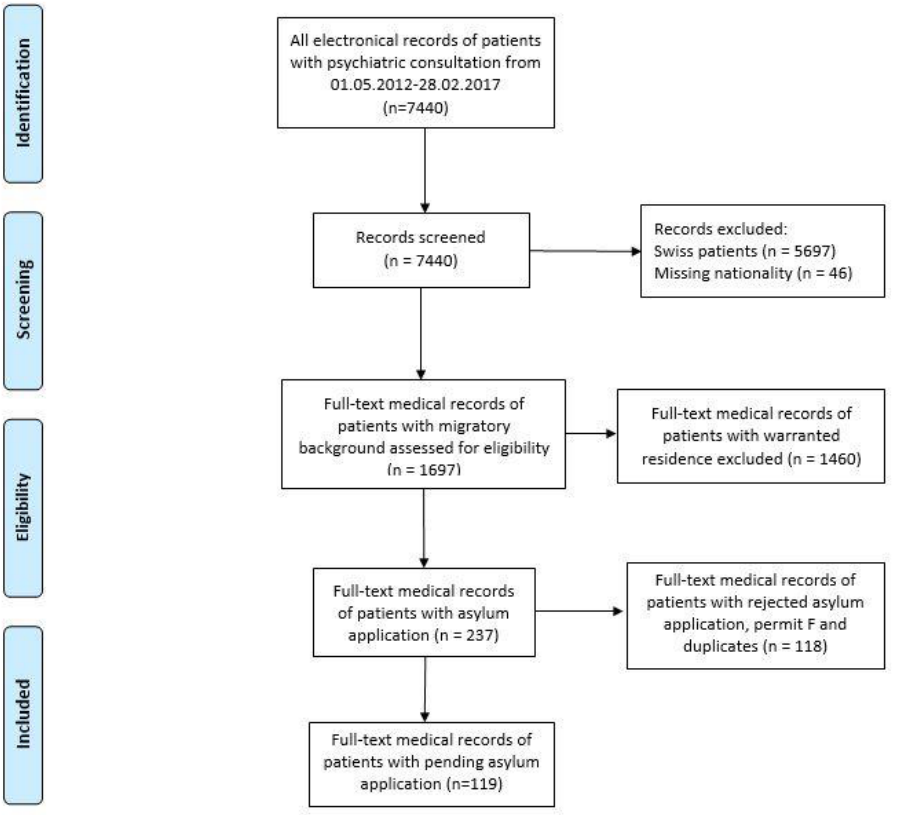
Figure 1. Medical records included in the analysis.